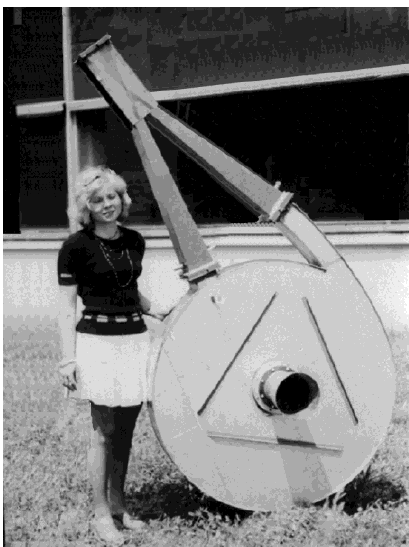
Fig. 19. Photograph of the bistable turn-down model valve made according to Fig. 18. The large size is necessary to keep low the velocities at which would be generated aerodynamic